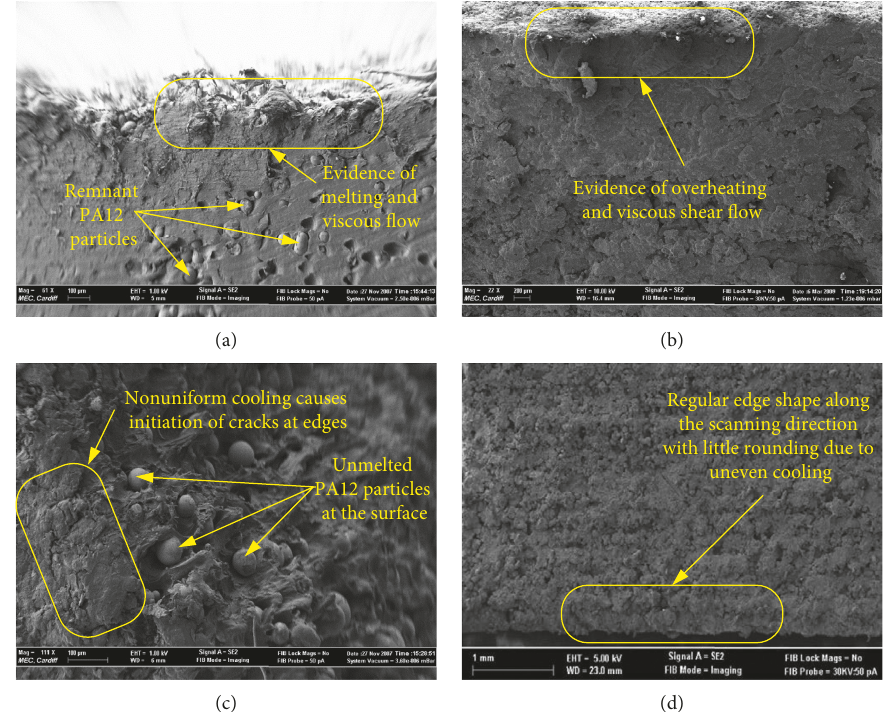
Figure 9: SEM micrograph showing the end-of-vector (EOV) effect in the SLS process; LP � 7 watt (ED � 0.051J/mm 2 ) at 10% weight fraction of white cement.